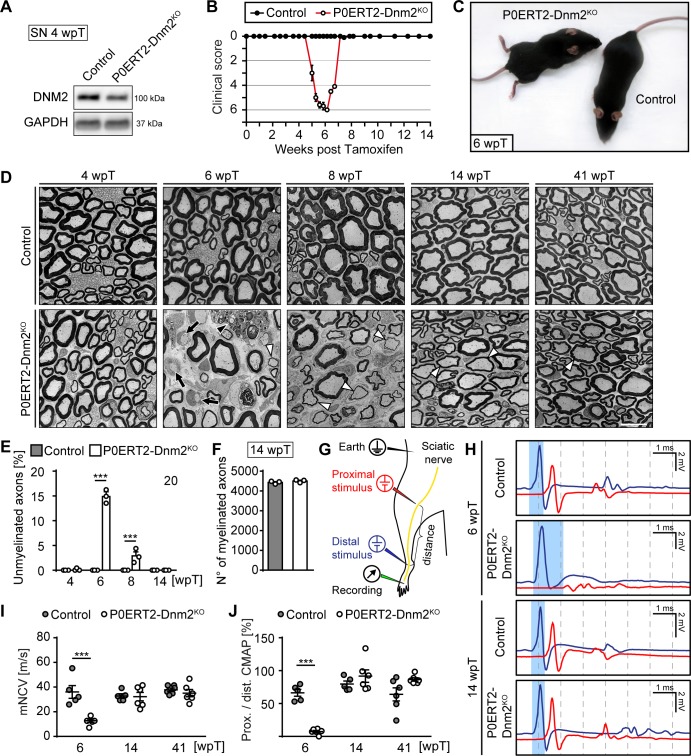
Schwann cell-specific ablation of dynamin 2 in adult mice causes a transient neuropathy.(A) Immunoblot analysis of DNM2 in SN extracts of Dnm2loxP/loxP (control) and MpzCreERT2:Dnm2loxP/loxP (P0ERT-Dnm2KO) mice at 4 weeks post tamoxifen (wpT). N = 3 mice/genotype. Quantification in Figure 2—figure supplement 1B, full-length blots in Supplementary file 1B. (B) Time line of functional impairments and recovery of P0ERT-Dnm2KO mice after tamoxifen treatment based on clinical assessments over 14 weeks. Clinical score: 0 = normal, 1 = less lively, 2 = impaired righting reflex, 3 = absent righting reflex, 4 = ataxic gait, 5 = mild paraparesis, 6 = moderate paraparesis, 7 = severe paraparesis. N = 5 mice/genotype. (C) Exemplary picture showing moderate paraparesis of a P0ERT-Dnm2KO mouse, but not of a control littermate at 6 wpT. (D) Exemplary EM images showing ultrastructure of control and P0ERT2-Dnm2KO SN cross-sections at the indicated time points. N = 3 mice/time point and genotype. Black arrows: Unmyelinated axons; white arrowheads: Thinly melinated axons associated with remyelinating SCs; black arrowhead points to a macrophage. Scale bar = 10 μm, referring to entire panel. (E) Quantification of unmyelinated axons relative to total number of axons with calibers > 1 μm. At least 200 axons/sample were analyzed (random EM fields). N = 3 mice/time point and genotype, Two-Way ANOVA with Sidak’s multiple comparisons test. (F) Quantification of myelinated fibers/SN cross-section at 14 wpT. N = 3 mice/genotype, two-tailed unpaired Student’s t-test. (G) Schematic drawing of the setup for electrophysiological measurements. (H) Representative traces of electrophysiological findings in control and P0ERT2-Dnm2KO mice SNs at 6 wpT and 14 wpT. At 6 wpT, impulse conduction appears almost completely blocked upon proximal stimulation in P0ERT2-Dnm2KO mice and only a small and dispersed compound muscle action potential (CMAP) was recorded. These deficits were restored at 14 wpT. The blue-shaded columns illustrate the slowing in nerve conduction at 6 wpT in a P0ERT-Dnm2KO mouse and the recovery to normal values at 14 wpT. Blue profile: CMAP upon distal stimulation, red profile: CMAP upon proximal stimulation. (I) Motor nerve conduction velocity (mNCV) in control and P0ERT-Dnm2KO mice at the indicated time points. mNCV is reduced in P0ERT-Dnm2KO mice at 6 wpT, but is restored at 14 wpT. N = 5–6 mice/group, Two-Way ANOVA with Sidak´s multiple comparisons test. (J) Conduction block is indicated by severe reduction of the proximal to distal CMAP ratio in P0ERT-Dnm2KO mice at 6 wpT. This is resolved by 14 wpT. N = 5–6 mice/group, Two-Way ANOVA with Sidak´s multiple comparisons test. Results in graphs represent means ±s.e.m.; ***p<0.001.10.7554/eLife.42404.006Figure 2—source data 1.Phenotypical assessment of control and P0ERT-Dnm2KO mice over a period of 14 weeks after tamoxifen treatment.Refers to panel B.